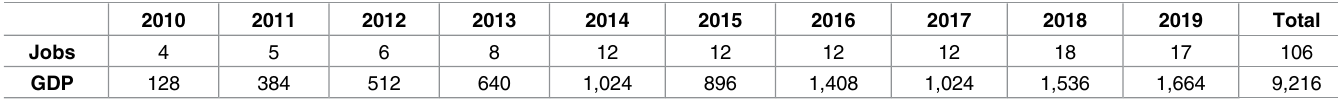
Table 6. REMI results indicating the macroeconomic impacts of the ORV program to New York State (GDP in thousands of